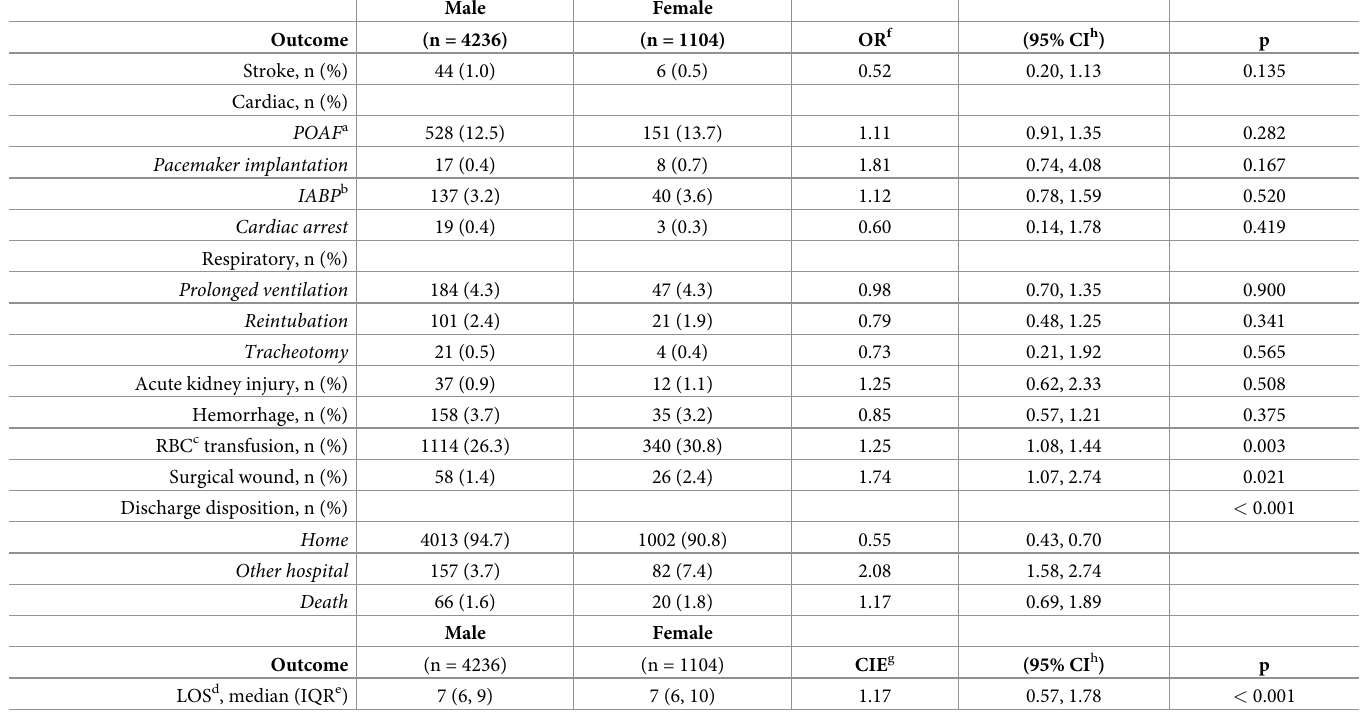
Table 3. Crude outcome analysis.